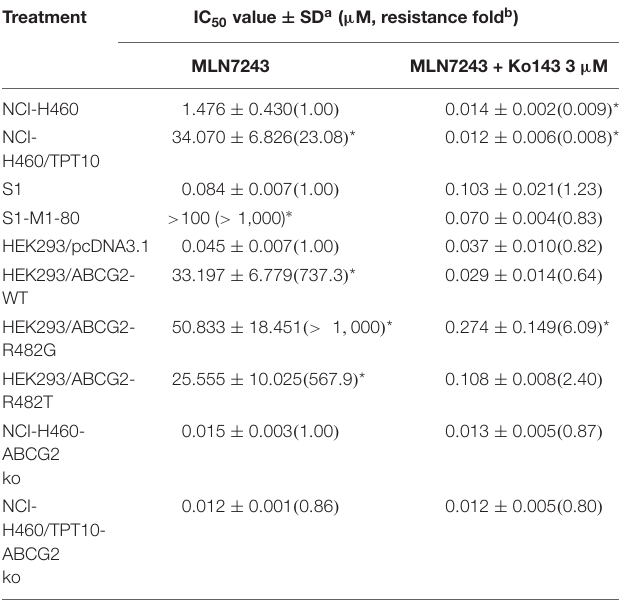
TABLE 1 | The cytotoxicity of MLN7243 in cells overexpressing the ABCG2 transporter. Treatment